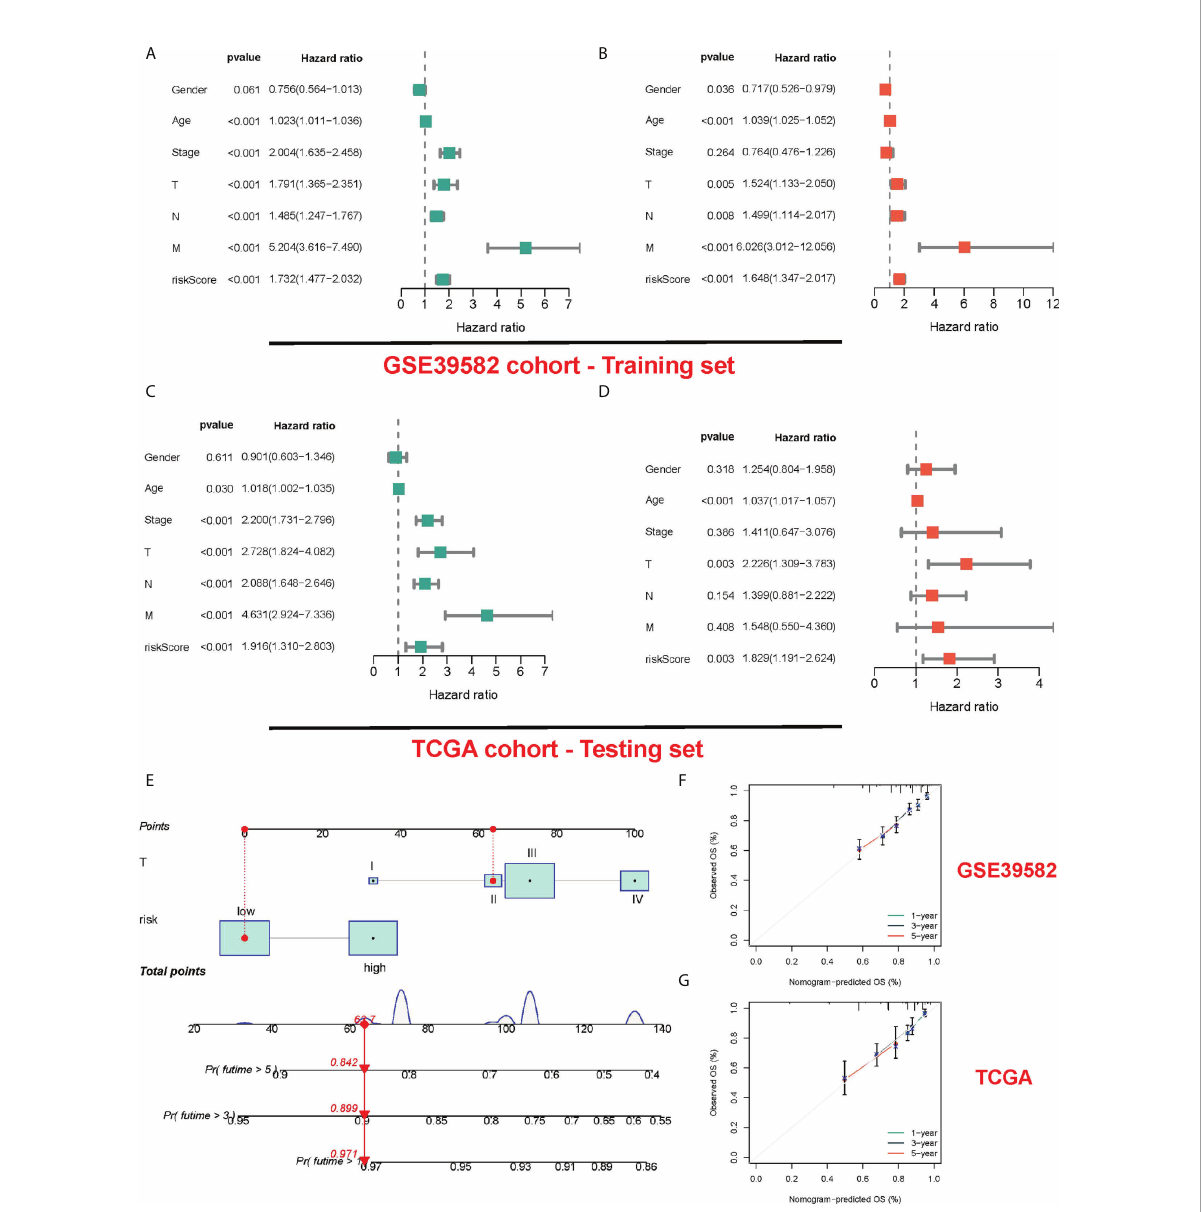
FIGURE 5 Construction and validation of a nomogram. (A, B) The results of the univariate and multivariate Cox regression analyses regarding signi fi cant survival-related clinical characteristic parameters in the GEO cohort. (C, D) The results of the univariate and multivariate Cox regression analyses regarding signi fi cant survival-related clinical characteristic parameters in the TCGA cohort. (E) The nomogram for predicting the survival probability of COAD patients. The calibration plots of the nomogram for predicting OS probability in GSE39582 cohort (F) and TCGA cohort (G)